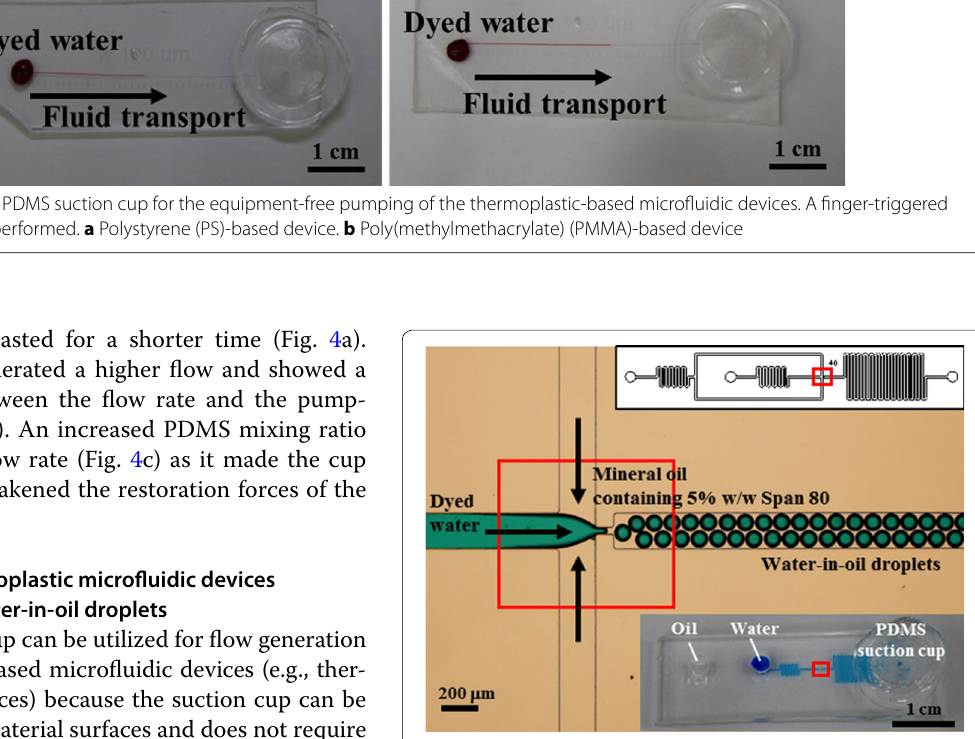
Fig. 6 Demonstration of the droplet generation. The water-in-oil droplets are continuously generated by pumping the fluids with the PDMS suction cup. The insets show the device geometry and snap- shot of the integrated microfluidic